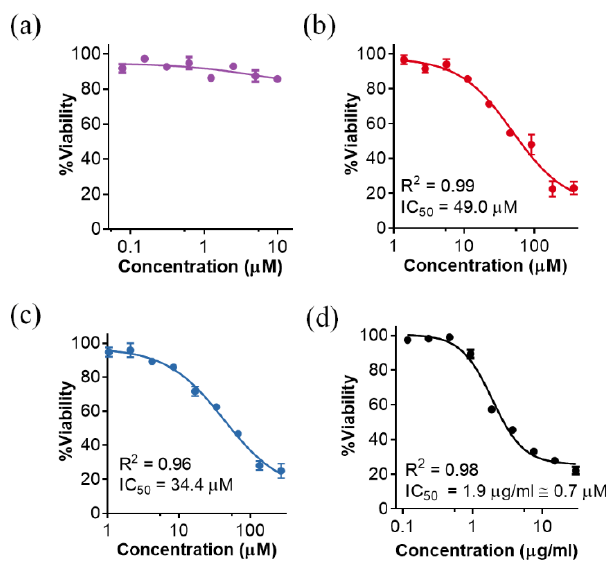
Figure 6. Cytotoxicity of different Pae87-based peptidic compounds on A549 cell cultures. The residual MTT measured viability with respect to an untreated control after 48 h treatment of A549 cells with different concentrations is shown: ( a ) Pae87; ( b ) P87; ( c ) P88; ( d ) melittin as a cell toxicity positive control. Actual data were non-linear fitted to a negative sigmoidal curve (with generalized equation Viability = 100/ ( 1 + 10 HillSlope × ( LogIC50 − Concentration ) ). In this way, IC 50 was calculated when the fitted sigmoid presented clear top and bottom sections [i.e., ( b – d )]. R 2 is also presented as a goodness of fit metric. Table 1. MICs of P88 and a range of antibiotics 1 against P. aeruginosa strains.